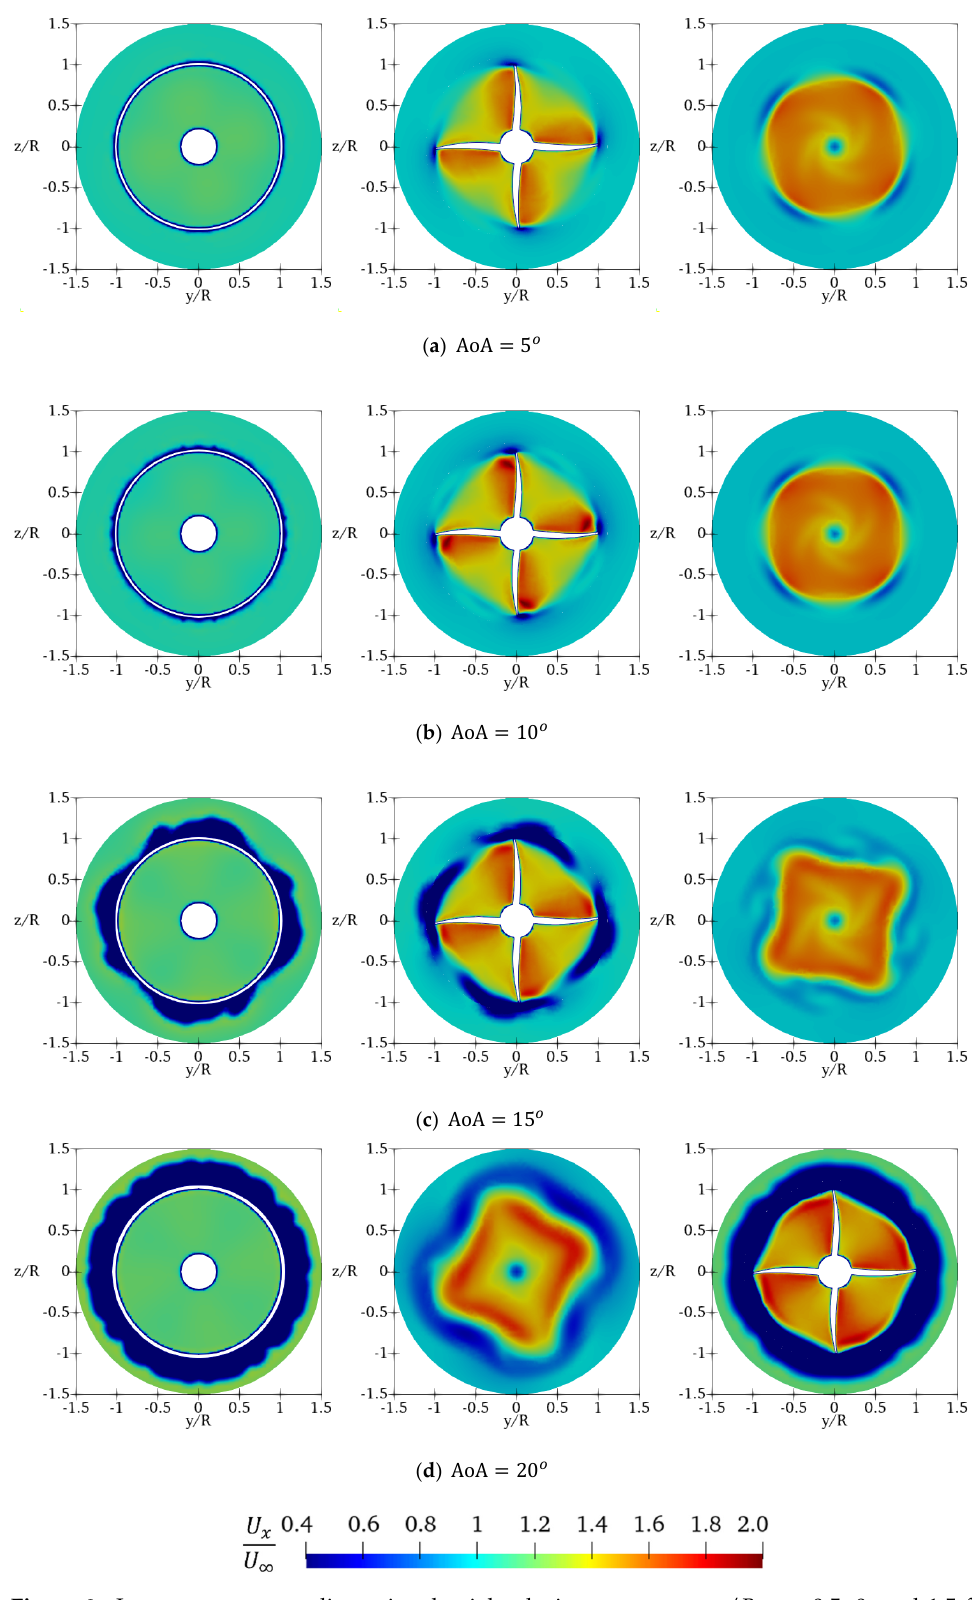
Figure 9. Instantaneous non-dimensional axial velocity contours at 𝑥/𝑅 = − 0.5, 0, and 1.5 for 𝐷 (cid:3005) = 𝐷 (cid:3017) (left: 𝑥/𝑅 = − 0.5; middle: 𝑥/𝑅 = 0 ; right: 𝑥/𝑅 = 1.5 ). Figures 10 and 11 show the pressure coefficient contours at y=0 plane for the cases with 𝐷 (cid:3005) = 0.7𝐷 (cid:3017) and 𝐷 (cid:3005) = 𝐷 (cid:3017) , respectively. The pressure coefficient showing a value of 𝐶 = − 1.763 represented regions with pressure lower than the saturation pressure. A (cid:3017) distinct decrease in the pressure coefficient on the suction side of the propeller was caused by the suction effect of the propeller on the inbound flow resulting in pressure below the vapor pressure and therefore cavitation. The low-pressure area was where the lowest value of 𝐶 (cid:3043) was equivalent to the cavitation number, and was dependent on the angle of attack. A higher pressure around the propeller tip on the pressure side increased with the increasing angle of attack of the duct, regardless of the size of the duct. ( a ) Without Duct ( b ) AoA = 5 (cid:3042) ( c ) AoA = 10 (cid:3042) ( d ) AoA = 15 (cid:3042)